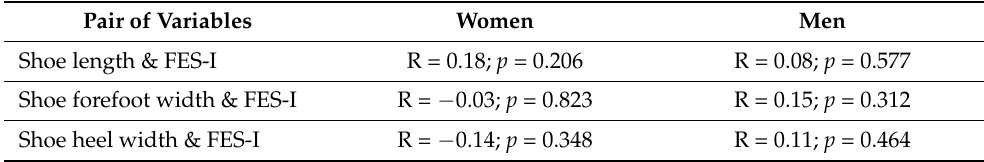
Table 5. Relationships between the subjective assessment of footwear comfort and the results of the